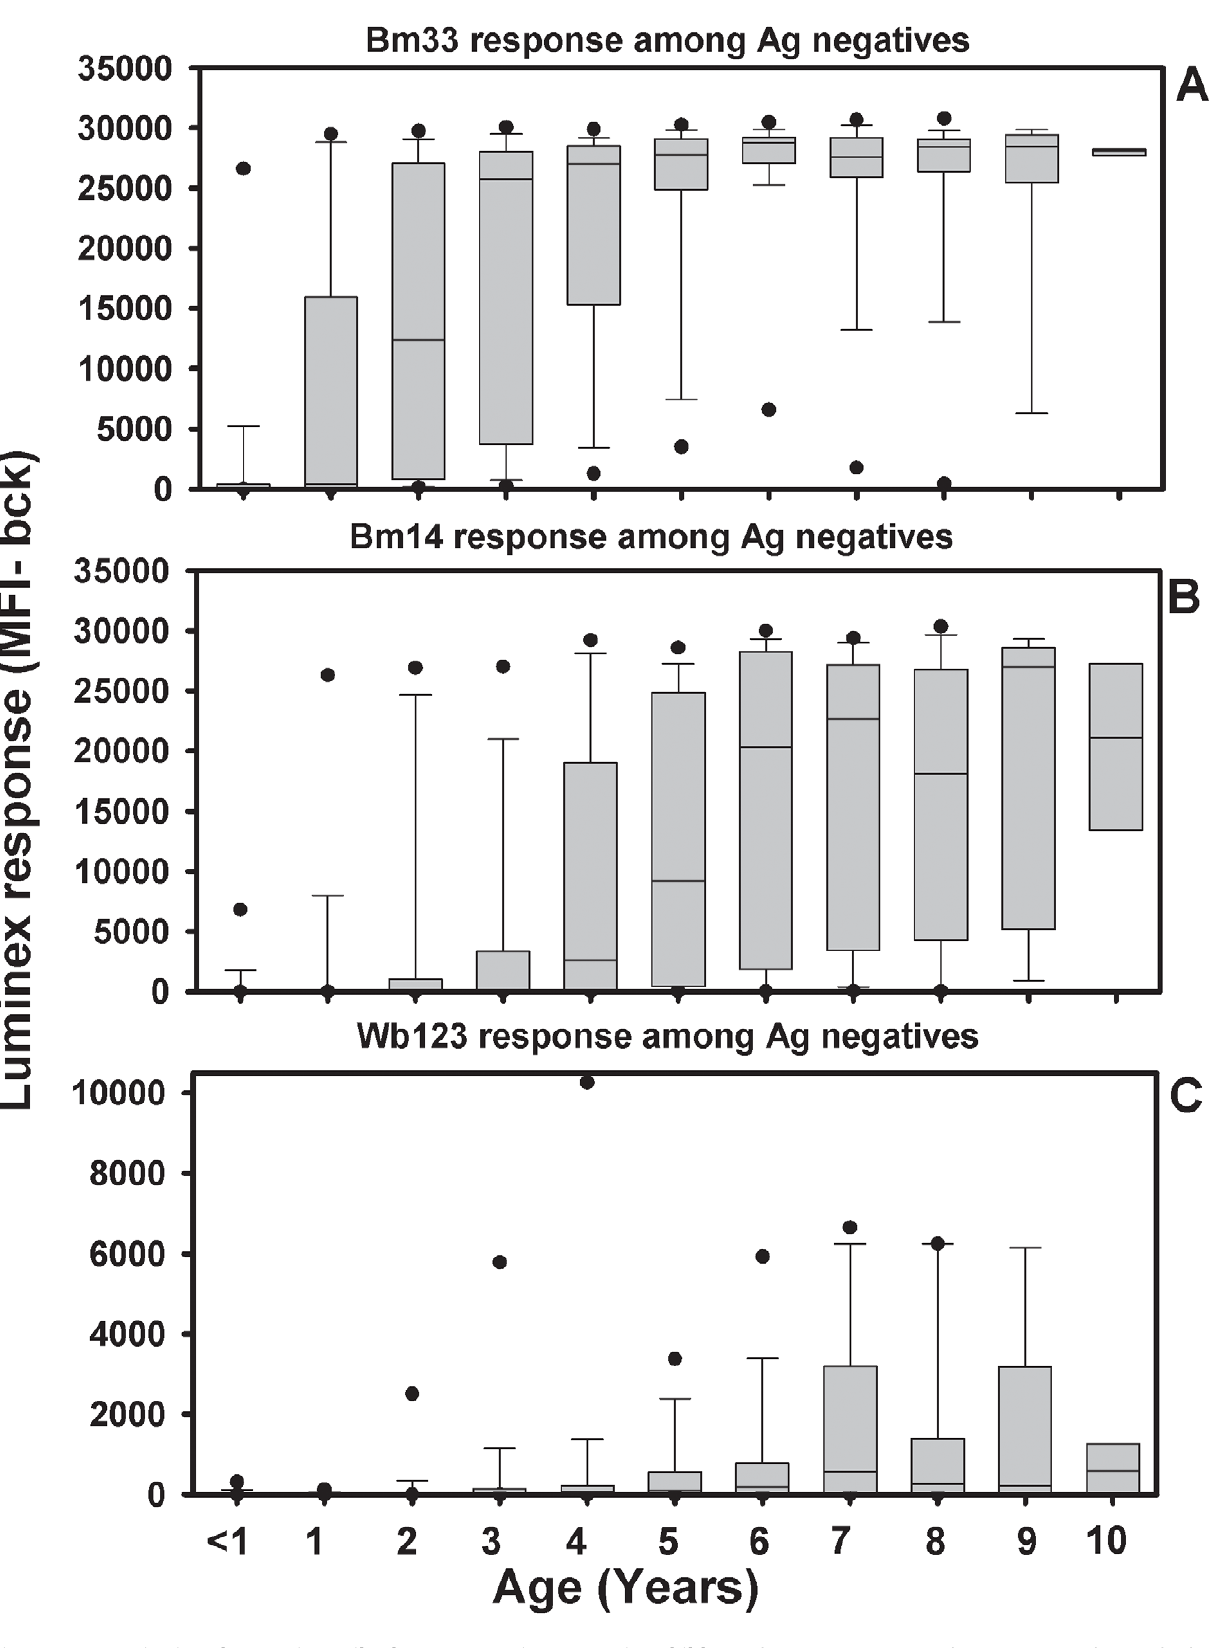
Figure 5. Quantitative changes in antibody among antigen-negative children. Shown are Bm33 (panel A), Bm14 (panel B), and Wb123 (panel C) antibody levels by age for antigen-negative children. In this plot, boxes represent the 25 th –5 th percentile with the line in the box, the median. Whiskers represent the10 th and 90 th percentile and filled circles are 5 th and 95 th percentile. doi:10.1371/journal.pntd.0001941.g005 PLOS Neglected Tropical Diseases |